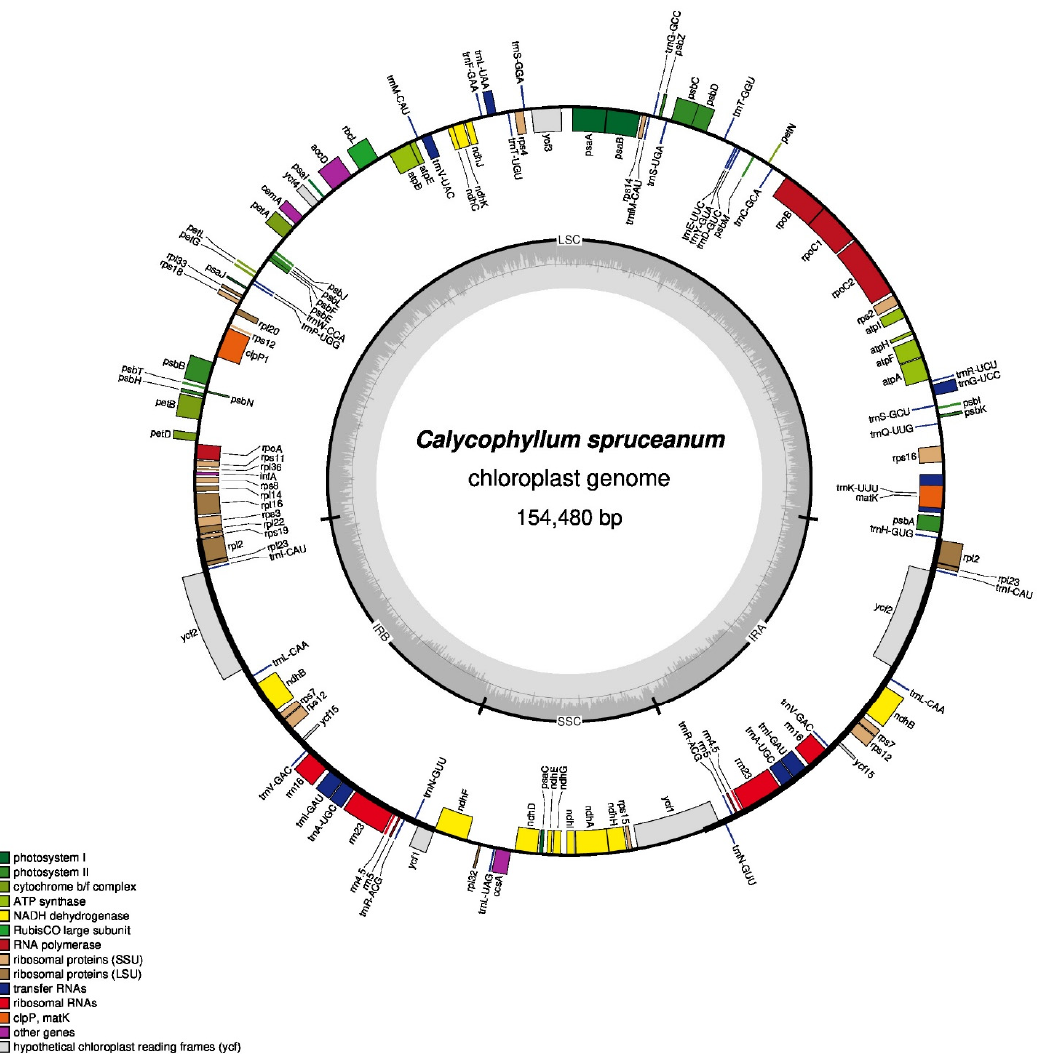
Figure 1. Gene map of C. spruceanum . Genes lying outside the outer circle are transcribed in a counter-clockwise direction, and genes inside this circle are transcribed in a clockwise direction. The colored bars indicate known protein-coding genes, transfer RNA genes, and ribosomal RNA genes. LSC, large single-copy; SSC, small single-copy; IR, inverted repeat. As expected, the duplicated IR of the C. spruceanum chloroplast genome resulted in complete duplication of 18 genes: five protein-coding genes such as rpl2 , rpl23 , rps7 , rps12 , and ndhB ; seven tRNAs as trn I-CAU, trn L-CAA, trn V-GAC, trn I-GAU, trn A-UGC, trn R- AGC, and trn N-GUU; four rRNAs genes as rrn 23, rrn 16, rrn 5, rrn 4.5 (see Figure 1), and 5 ′ end of ycf1 . The SSC region contained 12 protein-coding and one tRNA gene, whereas LSC region contained 69 protein-coding and 22 tRNAs. Codon usage analysis identified a total of 26,572 codons in the C. spruceanum chloro- plast genome. Among all codons, leucine (Leu) was the most abundant amino acid with a frequency of 10.62%, followed by isoleucine (Ile) with a frequency of 8.40%, whereas cys- teine (Cys) was less abundant with a frequency of 1.14%. Moreover, only one codon was identified for methionine (Met) and tryptophan (Trp) amino acids. Thirty codons were